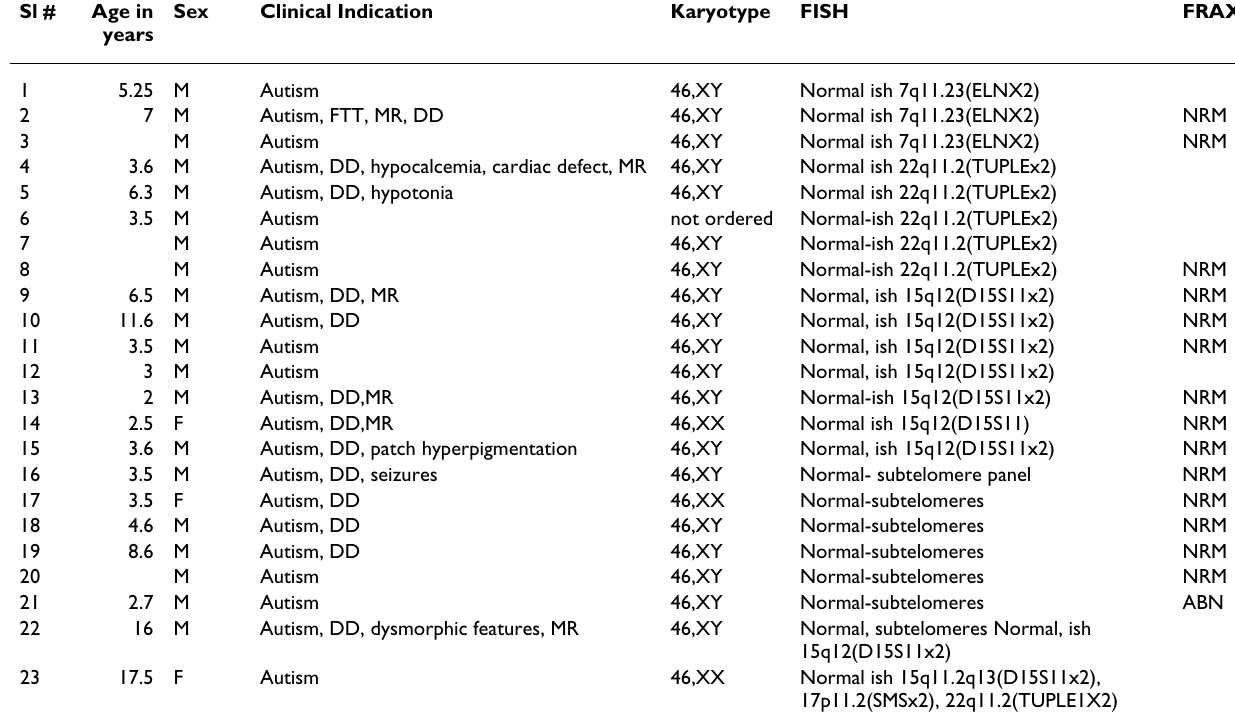
Table 3: Summary of FISH